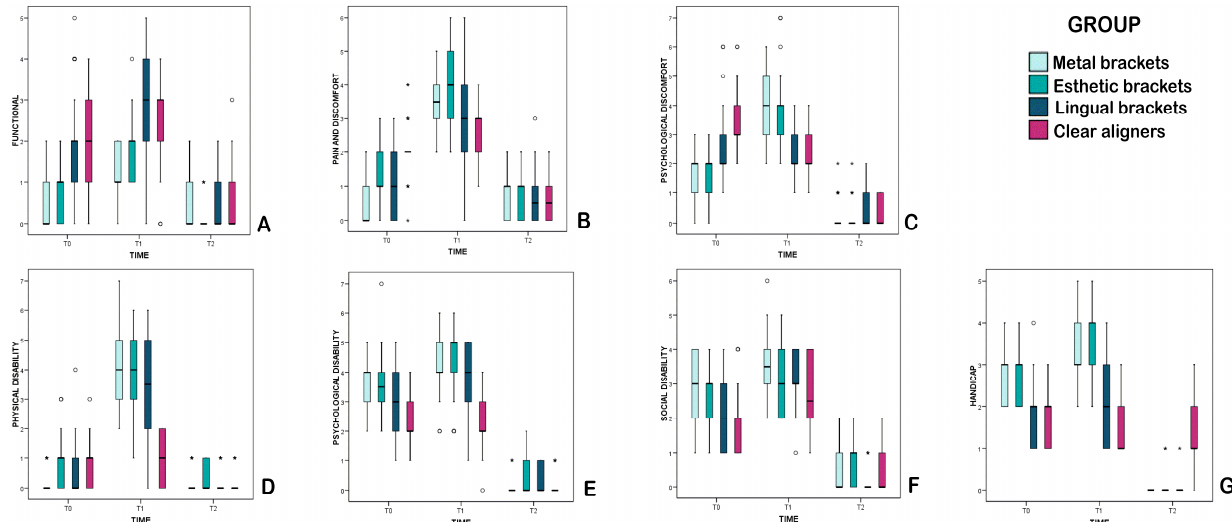
Figure 2. Results for each of the seven OHIP-14 domains evaluated for each type of orthodontic treatment (( A ) : functional limitation; ( B ): physical pain; ( C ): psychological discomfort; ( D ): physical disability; ( E ): psychological disability; ( F ): social disability; ( G ): handicap). ° atypical values; * extreme values.